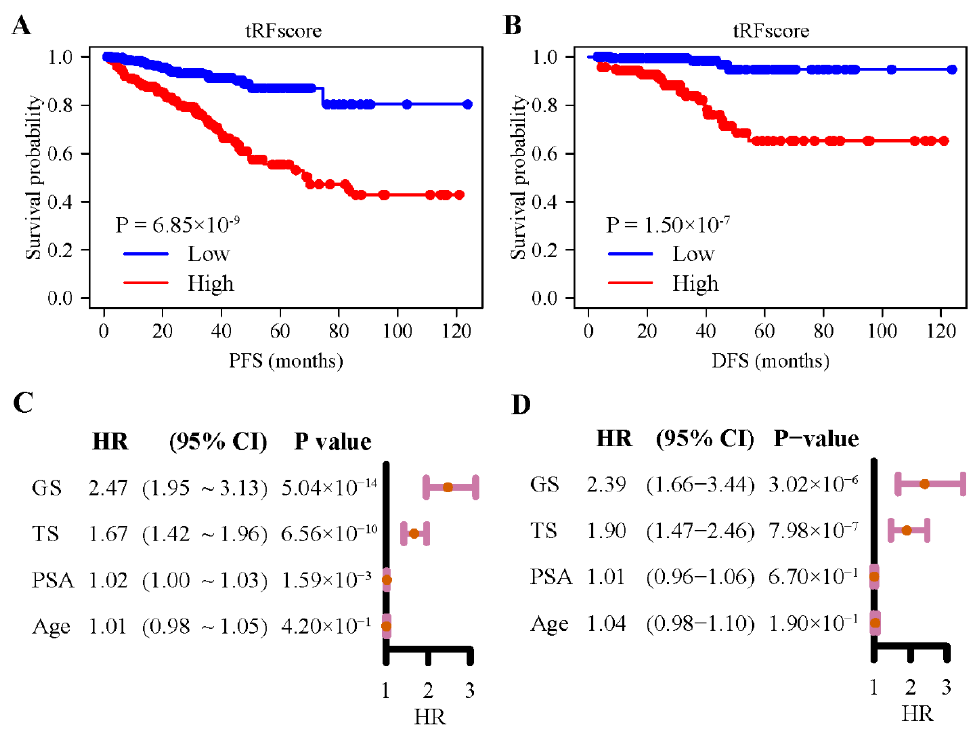
Figure 3. Expression of 5ʹ-tRFs is a prognostic biomarker for PRAD. ( A , B ) Kaplan–Meier curves of PFS ( A ) and DFS ( B ) of PRAD patients with low vs. high tRF score. ( C , D ) Hazard ratios (HR) and their 95% confidence interval (CI) of GS, TS, PSA, and age from the univariate Cox regression model for PFS ( C ) and DFS ( D ). PFS: progression-free survival; DFS: disease-free survival; TS: tRF score; GS: Gleason score; PSA: serum prostate-specific antigen.